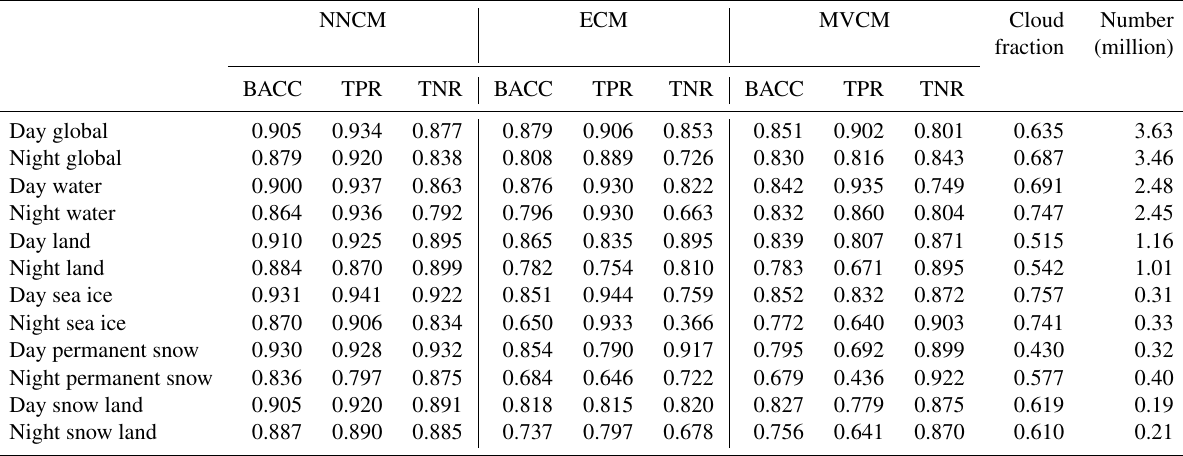
Table 6. Same as Table 5, but all metrics are computed for the unfiltered collocations. NNCM ECM MVCM Cloud Number